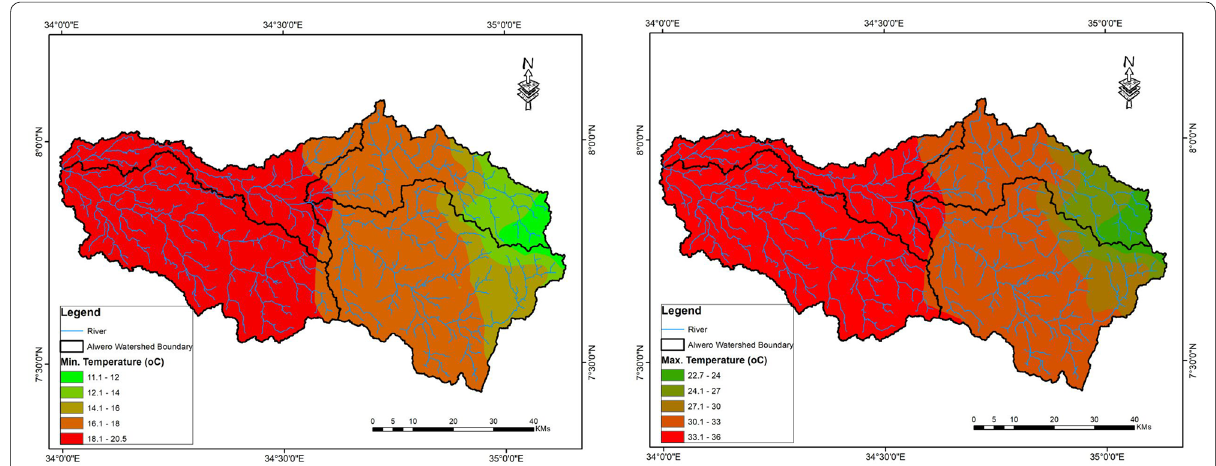
Fig. 8 Spatial distribution of maximum (left) and minimum (right) temperatures in Alwero